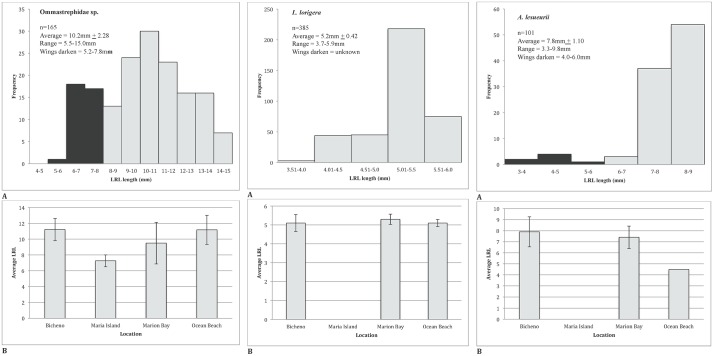
(A) Frequency histograms of the lower rostral lengths (LRLs) of the three most important squid species in the diet of LFPWs stranded in Tasmanian waters: Ommastrephidae spp., Lycoteuthis lorigera and Ancistrocheirus lesueurii, for all four stranding locations combined. Shaded areas show the young beaks with undarkened wings (unknown LRL for L. lorigera). (B) Average LRL (±SD) of the three most important squid species in the diet of LFPWs stranded in Tasmanian waters, separated by stranding location.